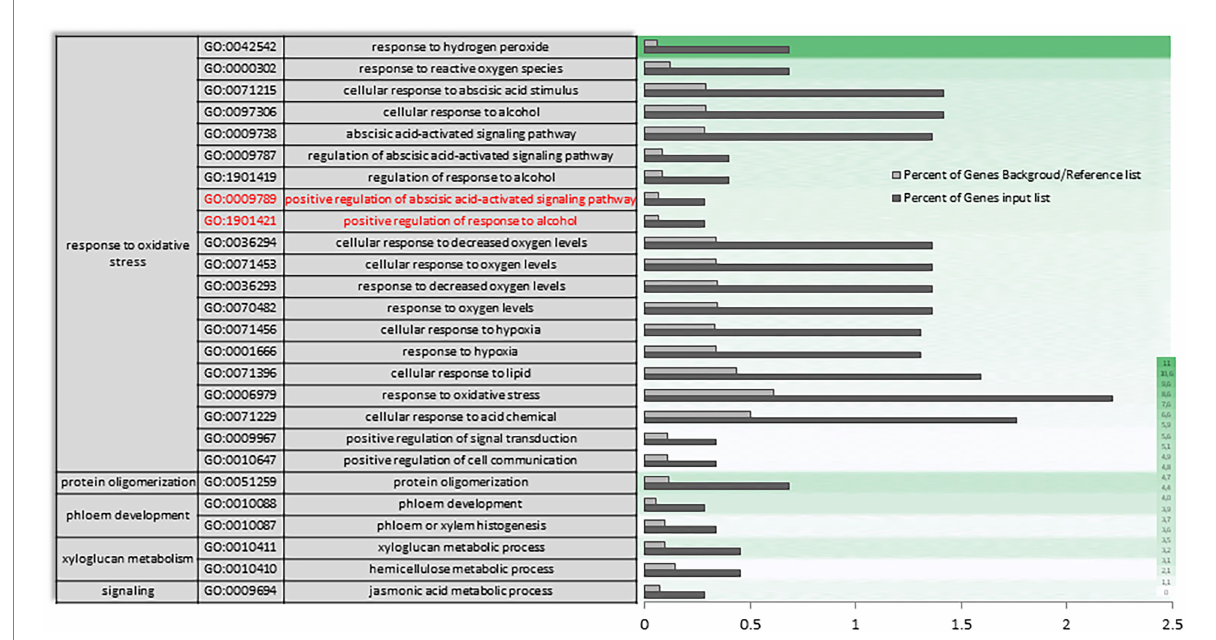
FIGURE 6 Specific gene ontology enrichment. DEGs obtained between fruit after harvest (AH) and CO 2 -cold stored (CCS). Bar chart showing in detail the most significant biological processes terms overrepresented obtaining by a Singular Enrichment Analysis (SEA; FDR ≤ 0.05) in AH vs. CCS comparison. The Y -axis shows the definition of GO terms. The X -axis is the percentage of genes mapped by the term, and represents the abundance of the GO term. The percentage for the input list is calculated by the number of genes mapped to the GO term divided by the number of all genes in the input list. The same calculation was applied to the reference list to generate its percentage. These two bars are classificated by a color key showing a green gradient scale for the frequency between both percentages represented.